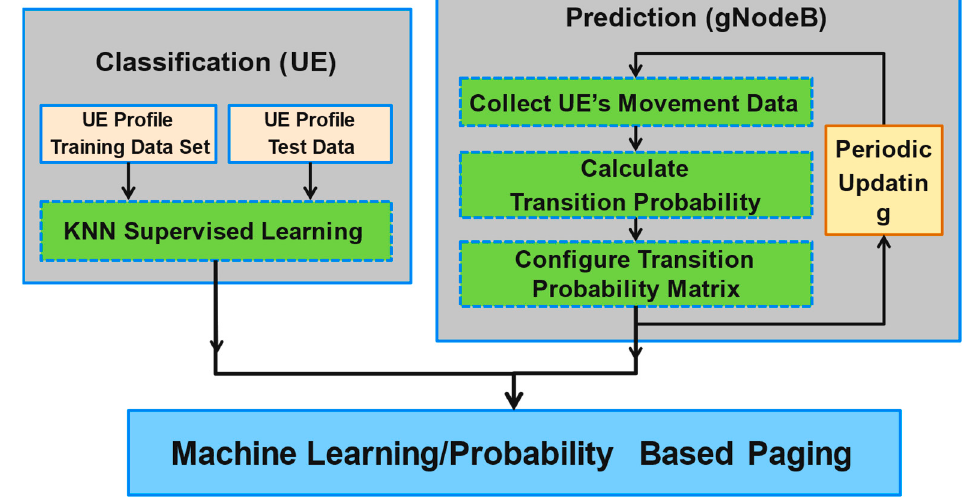
Figure 6. Algorithm of proposed machine learning-based paging.